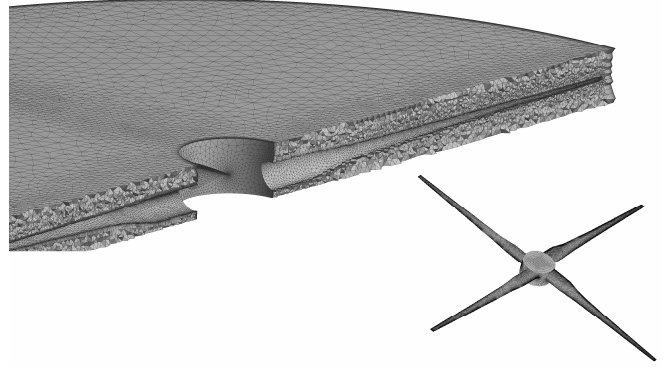
Figure 2. Grids of the turbine zone.